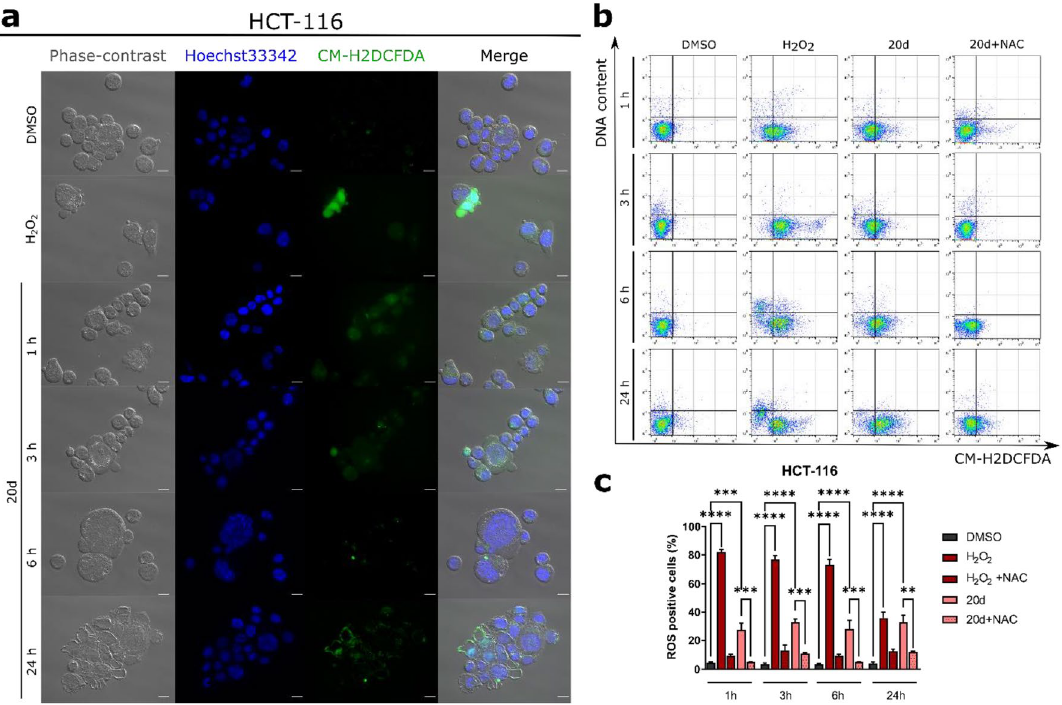
H2DCFDA-stained HCT-116 cells. DMSO and H 2 O 2 were used as reference compounds. ( c ) Quantification of dot plots is depicted as mean ± SEM of data obtained from three independent